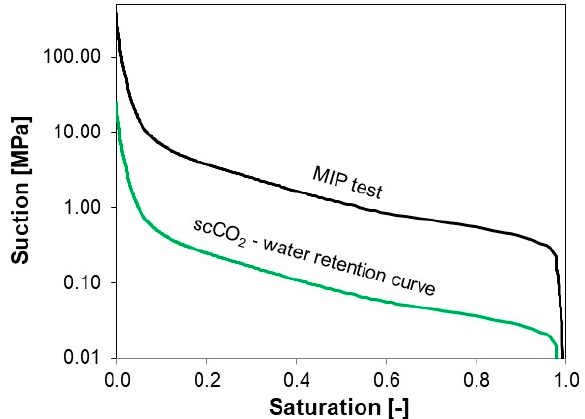
Figure 2. Retention curves obtained from mercury intrusion porosimetry and calculated curve that considers capillary properties of carbon dioxide (CO 2 ) in water-saturated carbonate rock.